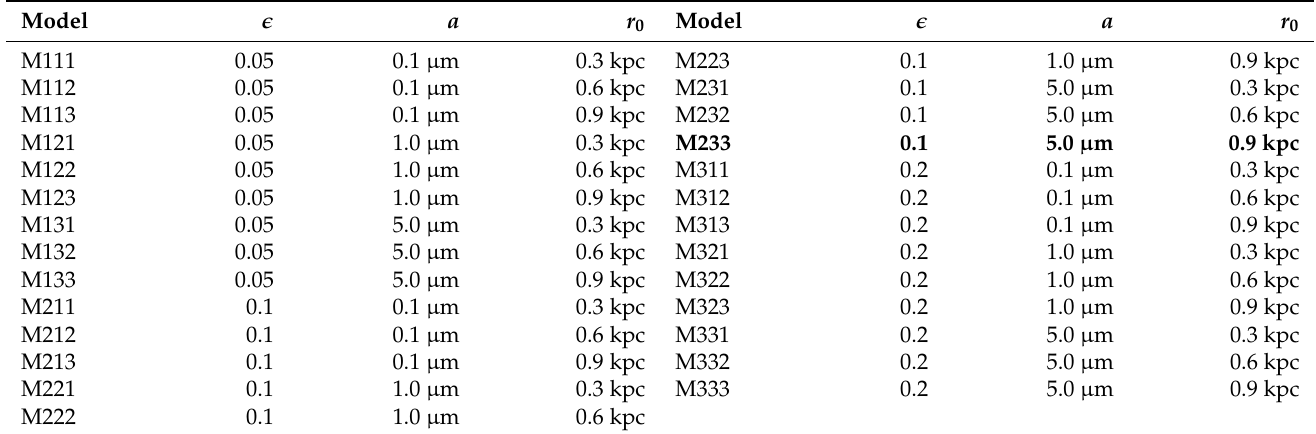
Table 1. The parameters of the circumnuclear disk of NGC 4736 used in our